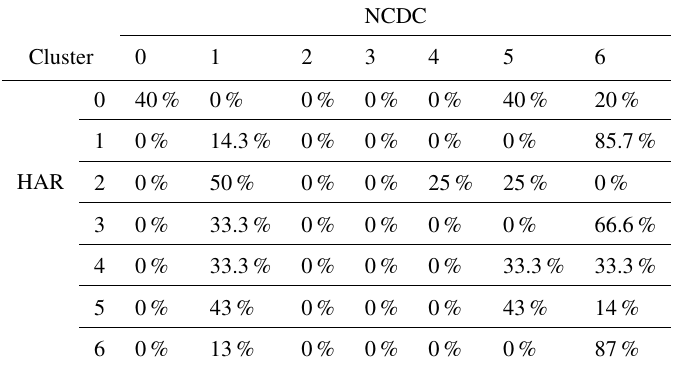
Table 1. The percentage of NCDC stations falling in each of the seven possible HAR clusters. A value of 100% would mean that all NCDC stations falls in the same cluster as the nearest HAR grid